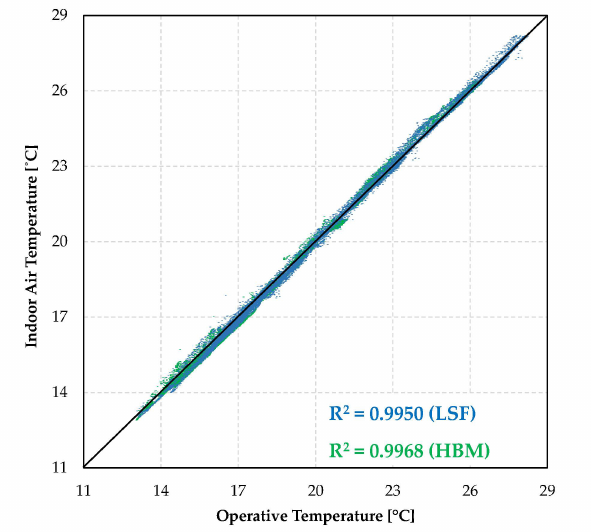
Figure 3. Correlation between the indoor air temperature and operative temperature for the LSF and HBM experimental test